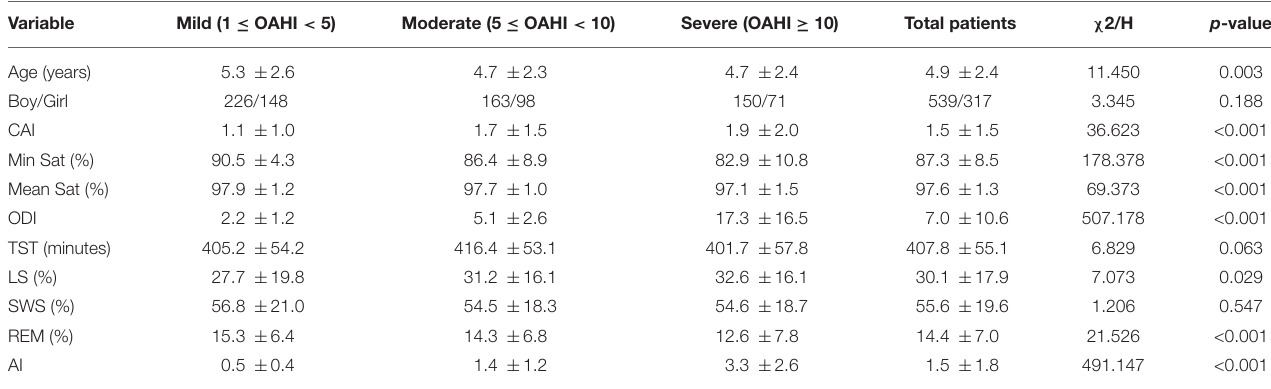
TABLE 1 | Demographic and sleep parameter differences between the mild, moderate and severe pediatric OSA groups. Variable